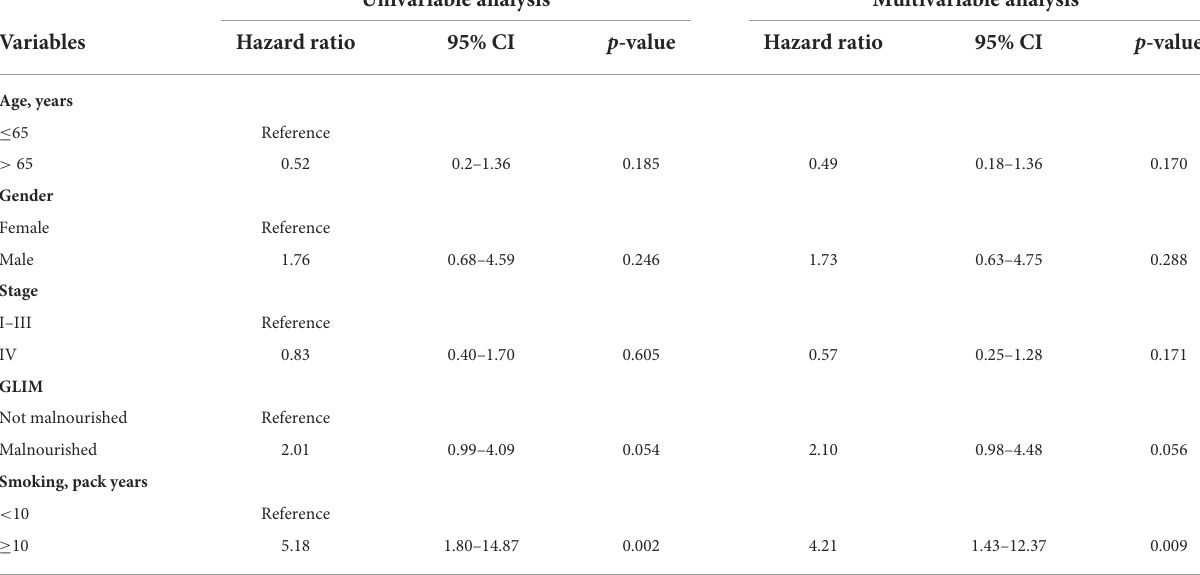
TABLE 5 Univariable and multivariable regression analysis of disease-free survival in 64 # HNC patients. Univariable